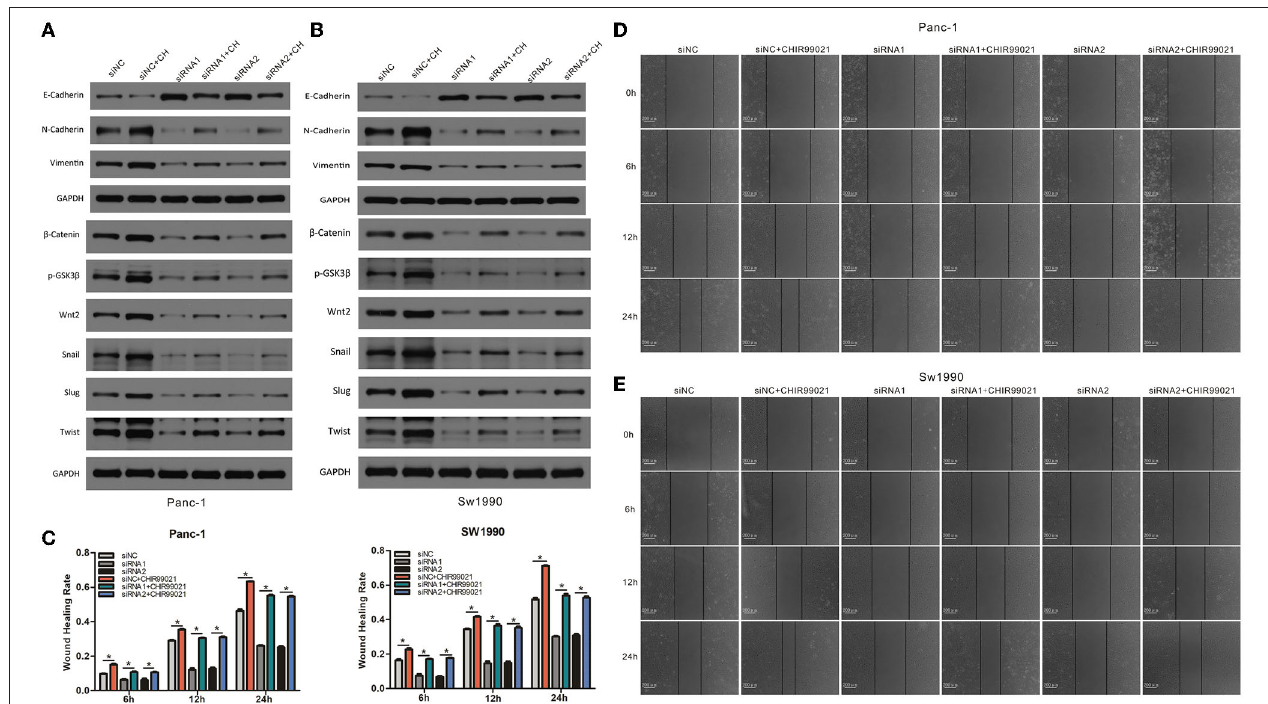
FIGURE 8 | CAPN2 induces EMT and metastasis through Wnt/ β -catenin signaling. (A,B) Western blot analysis shows increased levels of Wnt2, Snail1, Slug, TWIST, vimentin, and N-cadherin and reduced E-cadherin expression in CAPN2-silenced PC cells compared with that in control cells treated with CHIR-99021 (6 µ M, 24h). (C–E) Wound healing assays showed increased cell invasion capacities in CAPN2-silenced PC cells compared with that of control cells treated with CHIR-99021 (6 µ M, 24h). * P <